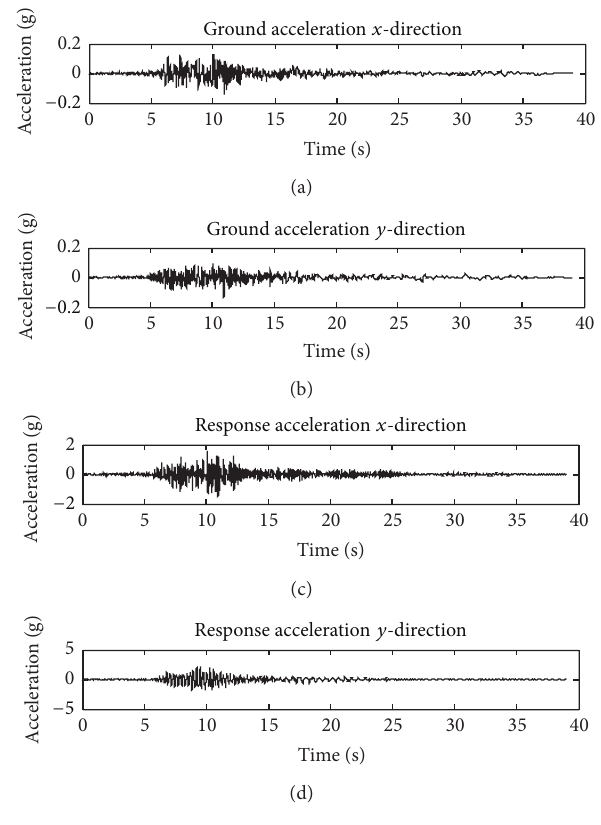
Figure 3: Components of ground motion acceleration and response acceleration of sensors 17 and